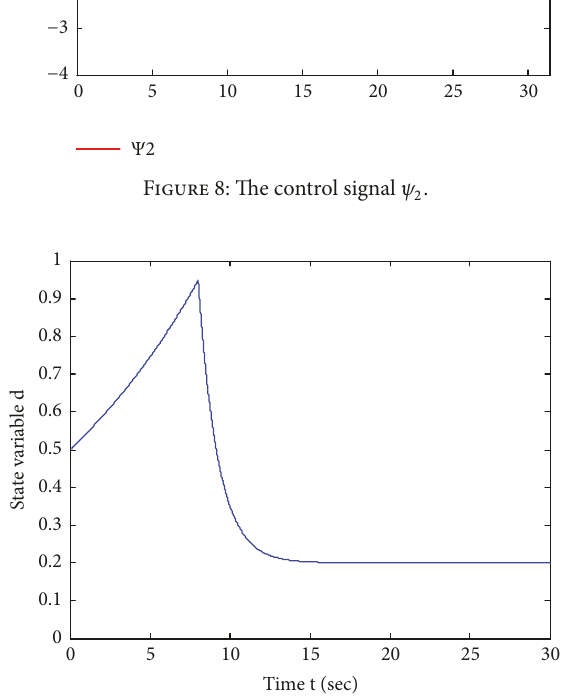
Figure 8: The control signal 𝜓 2 .